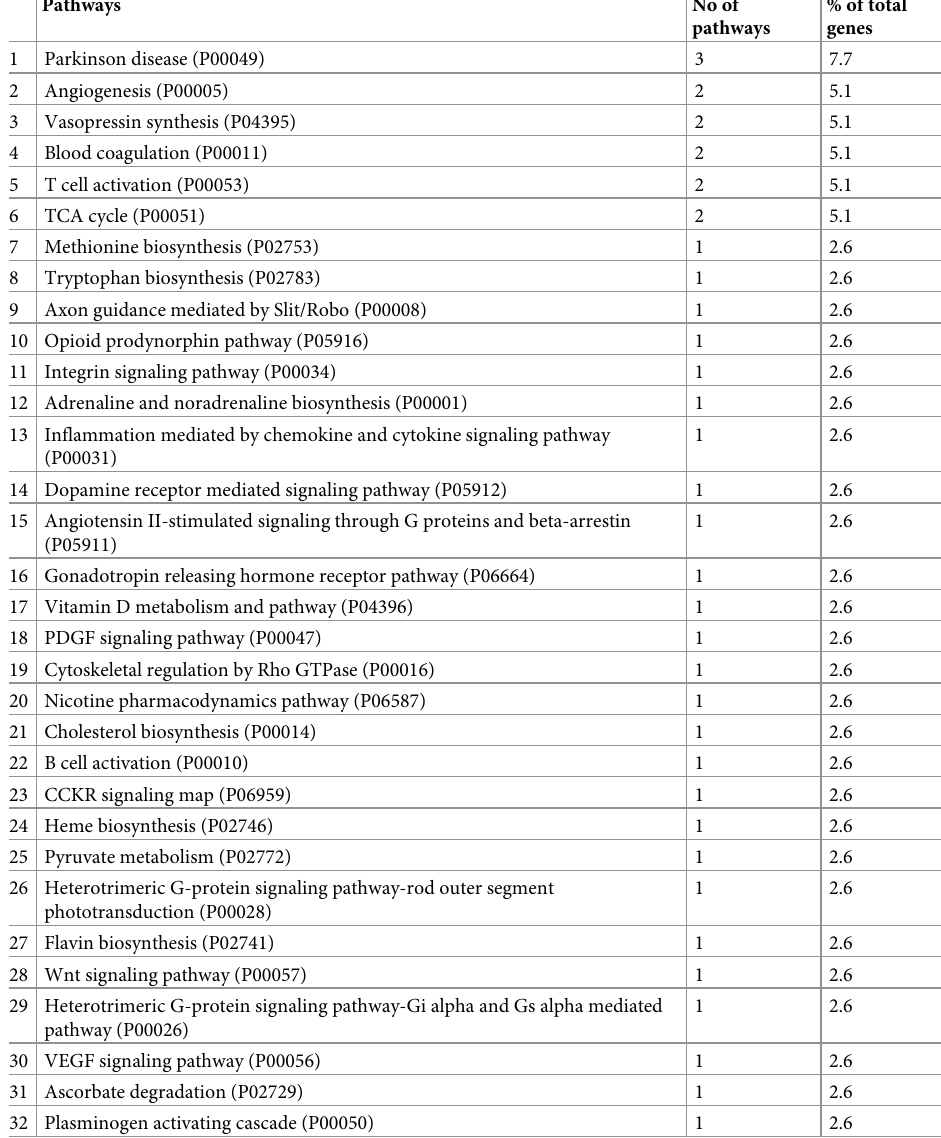
Table 3. Gene ontology functional classification of the total transcripts after de novo assembly, according to pathways. Pathways No of